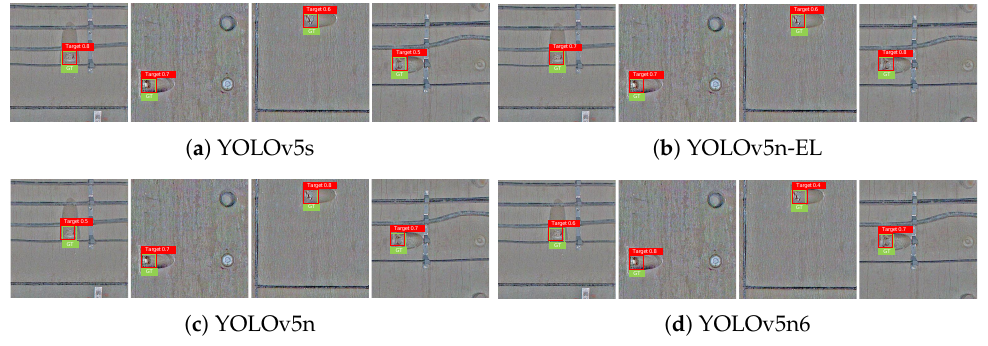
Figure 12. Examples of detection results with IMSRCR color